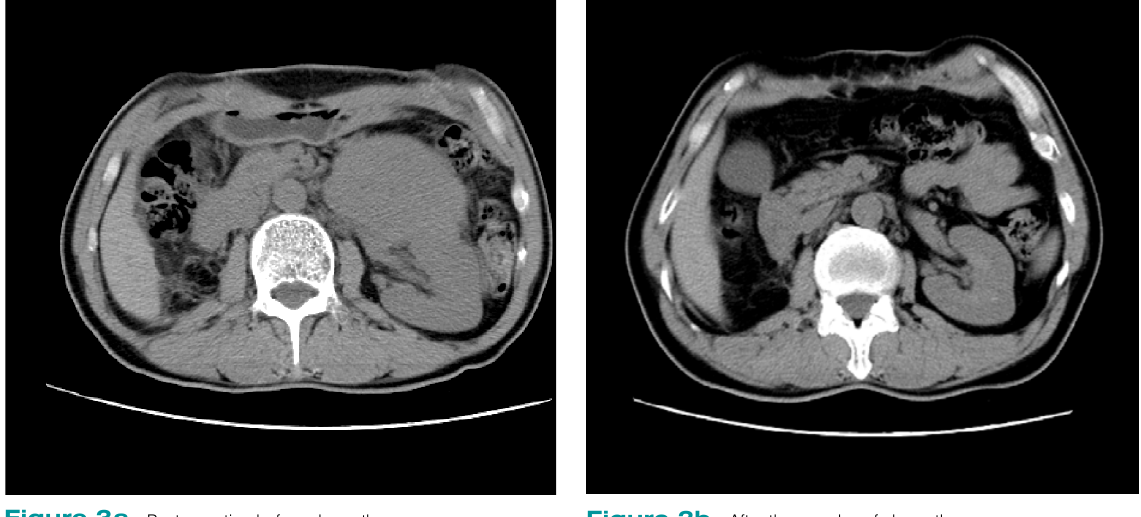
Figure 3a. Postoperation before chemotherapy Figure 3b. After three cycles of chemotherapy Figure 3. The patient received 6 cycles of chemotherapy using R-CHOP. After three cycles, complete remission was achieved (Figure